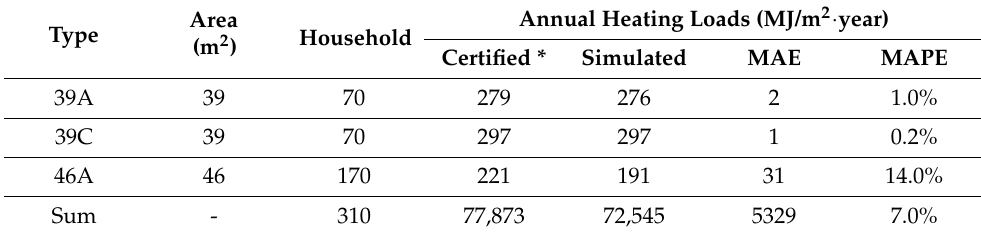
Table 6. Comparison of heating energy